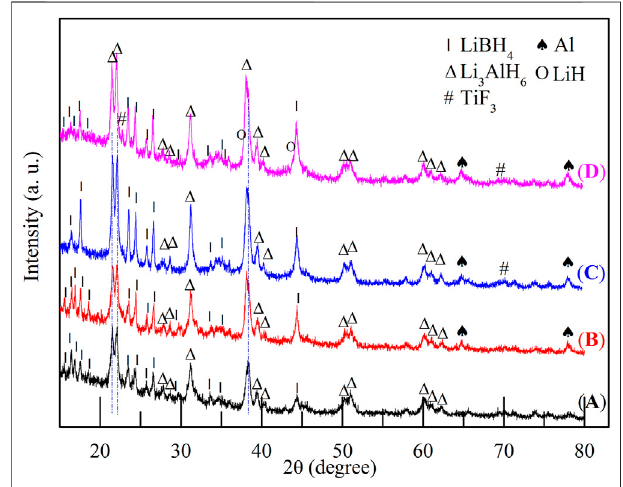
FIGURE 2 | XRD patterns of 2LiBH 4 – Li 3 AlH 6 samples with different amounts of TiF 3 after ball-milling: (A) 0 wt%, (B) 5 wt%, (C) 10 wt%, and (D) 15